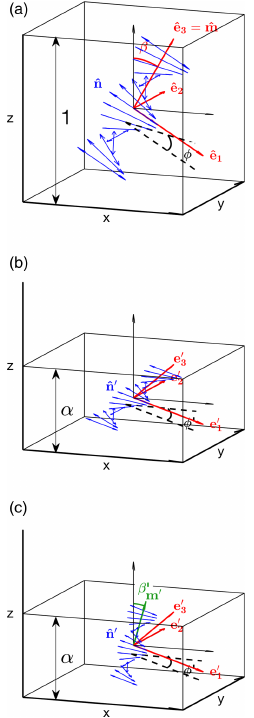
FIG.2. Schematicdiagramofatiltedandleft-handedcholesteric Figure 11. Illustration of the process of helix compression and axis reorientation upon drying a CNC domain (a) before deformation, (b) after a unidirectional compres- sion along ˆz scaling with a factor α , and (c) after redefining the helical axis as ˆm # . The directors ˆn and ˆn # are depicted by double- suspension after the kinetic arrest, following Frka-Petesic et al. [174]. The uncompressed state ( a ) headedarrows(inblue)toaccountfortheirsymmetrybyinversion. is compared to the state after uniaxial compression, showing representative director arrows that, thedish.Thedryingsuspensionisthuslaterallyconfinedand before compression, were perpendicular to the original helix ( b ), as well as arrows perpendicular should have no macroscopic distortions in the ( ˆx , ˆy ) plane. Wecannotcompletelyexcludethateachindividualcholesteric to the redefined helix representative of the compressed and deformed state ( c ). See main text domain that composes the kinetically trapped suspension couldlocallydistortinthe( ˆx , ˆy )planeastheyarecompressed. for further explanation. Reprinted figure with permission from [174], 045601-3